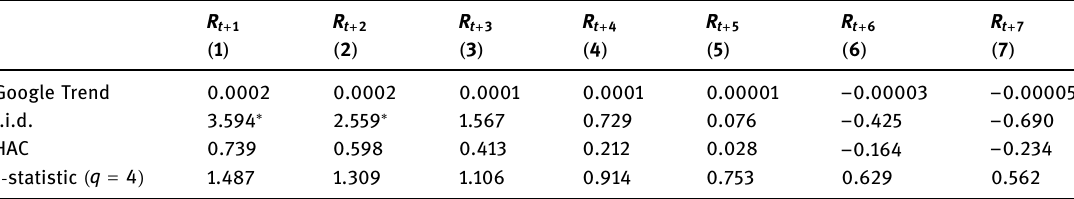
Table 8: Ethereum and Google